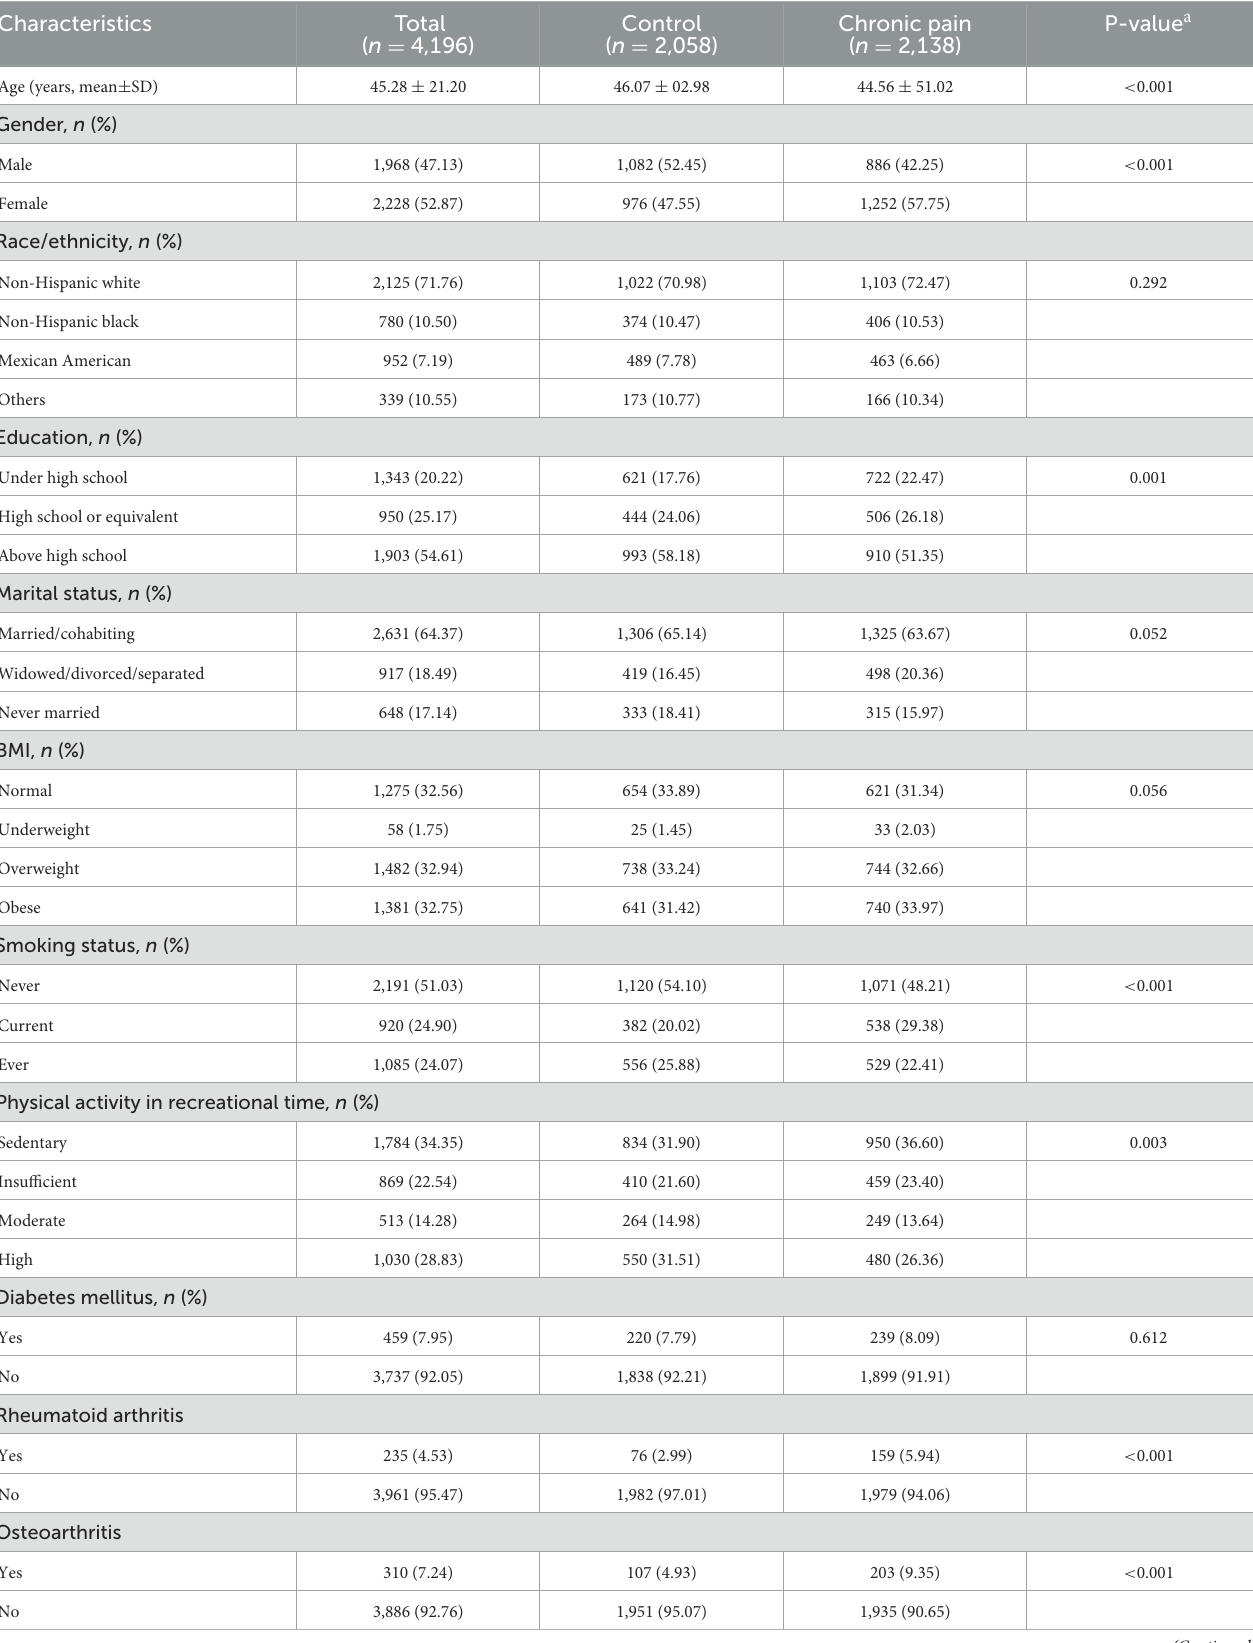
TABLE 1 Basic characteristics of participants in US adults, NHANES